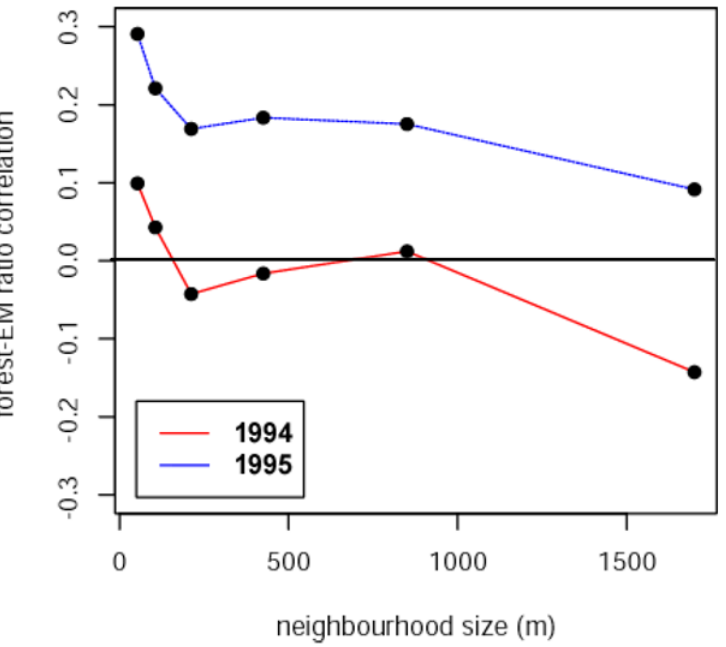
Figure 3. Correlation between forest tent caterpillar E/M ratios and forest cover measured over various neighbourhood sizes, from 53 m to 1700 m, for 1994 and 1995. The correlation between E/M and forest cover in 1994 switched from weakly positive at the shortest distance class (53 m) to weakly negative at the largest distance class (1700